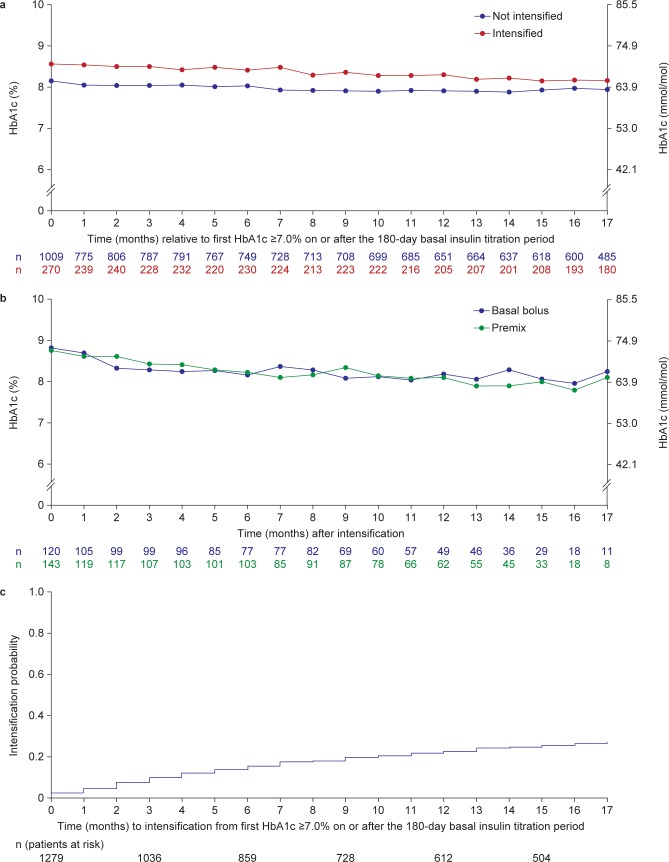
a. Mean HbA1c over time relative to first HbA1c ≥7.0% (≥53.0 mmol/mol) on or after the 180-day basal insulin titration period, stratified by intensification status; b. Mean HbA1c over time after treatment intensification; c. Time to treatment intensification after HbA1c ≥7.0% (≥53.0 mmol/mol). Fig 3A and 3B: n, number of patients contributing to each data point. HbA1c, glycated hemoglobin.